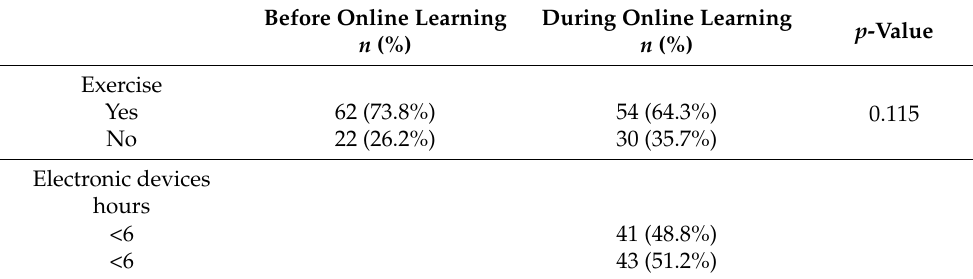
Table 2. Lifestyle before and during online distance learning.